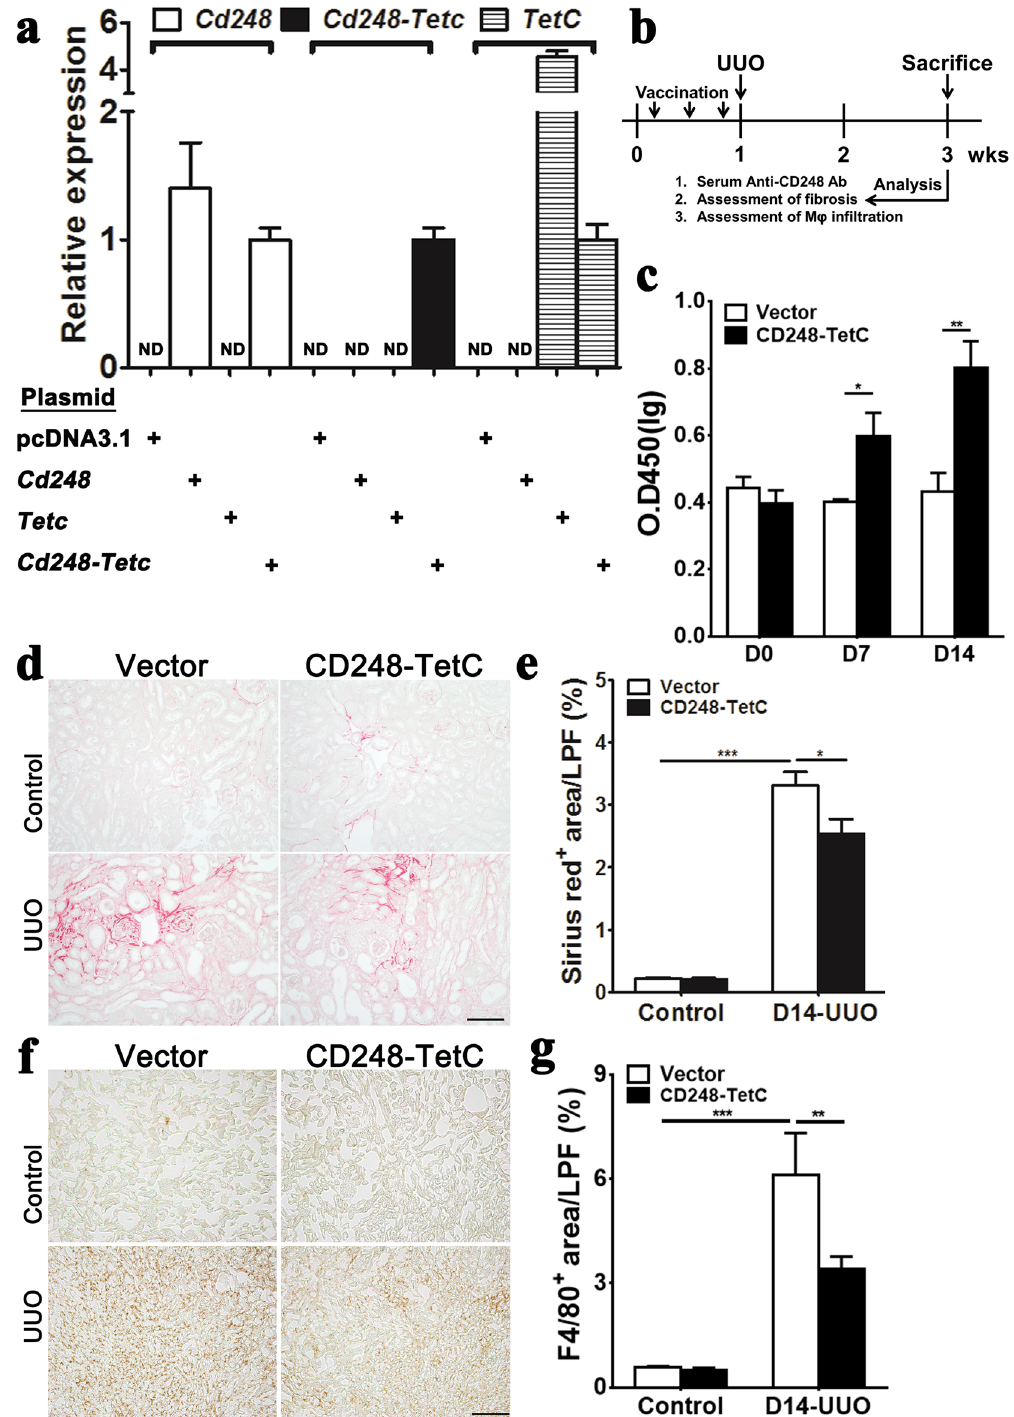
Figure 6. Cd248 DNA vaccination attenuated renal fibrosis. ( a ) qPCR of Cd248 , Cd248-Tetc and Tetc after plasmids were transfected into HEK293T cells. ND: no detection. ( b ) Schema illustrating Cd-248 DNA vaccination, UUO surgery, and analysis. ( c ) Plasma anti-CD248 antibody was detected by ELISA. ( d ) Representative images of picrosirius red staining in control and D14 UUO kidneys. ( e ) Quantification of Sirius red + collagen fibrils on LPF images of kidney sections. ( f ) Representative images of F4/80 + staining in control and D14 UUO kidneys. ( g ) Quantification of F4/80 + area on LPF images of kidney sections. The original magnification of representative images was × 100 in ( d , f ) and the LPF images of kidney sections were taken at 100× magnification in ( e , g ). Scale bar, 100 μm. Data are expressed as means ± standard errors of the mean. n = 8–10. * P < 0.05, ** P < 0.01 and *** P < 0.001 by unpaired t-test in ( c ) and one-way ANOVA with post hoc Tukey’s multiple comparisons test in ( e , g